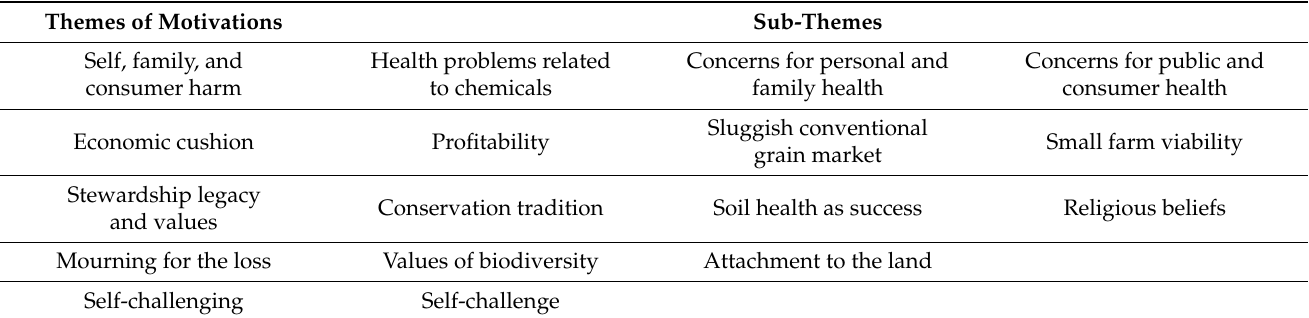
Table 2. Themes and Sub-themes of Motivations to Adopt Organic Grain